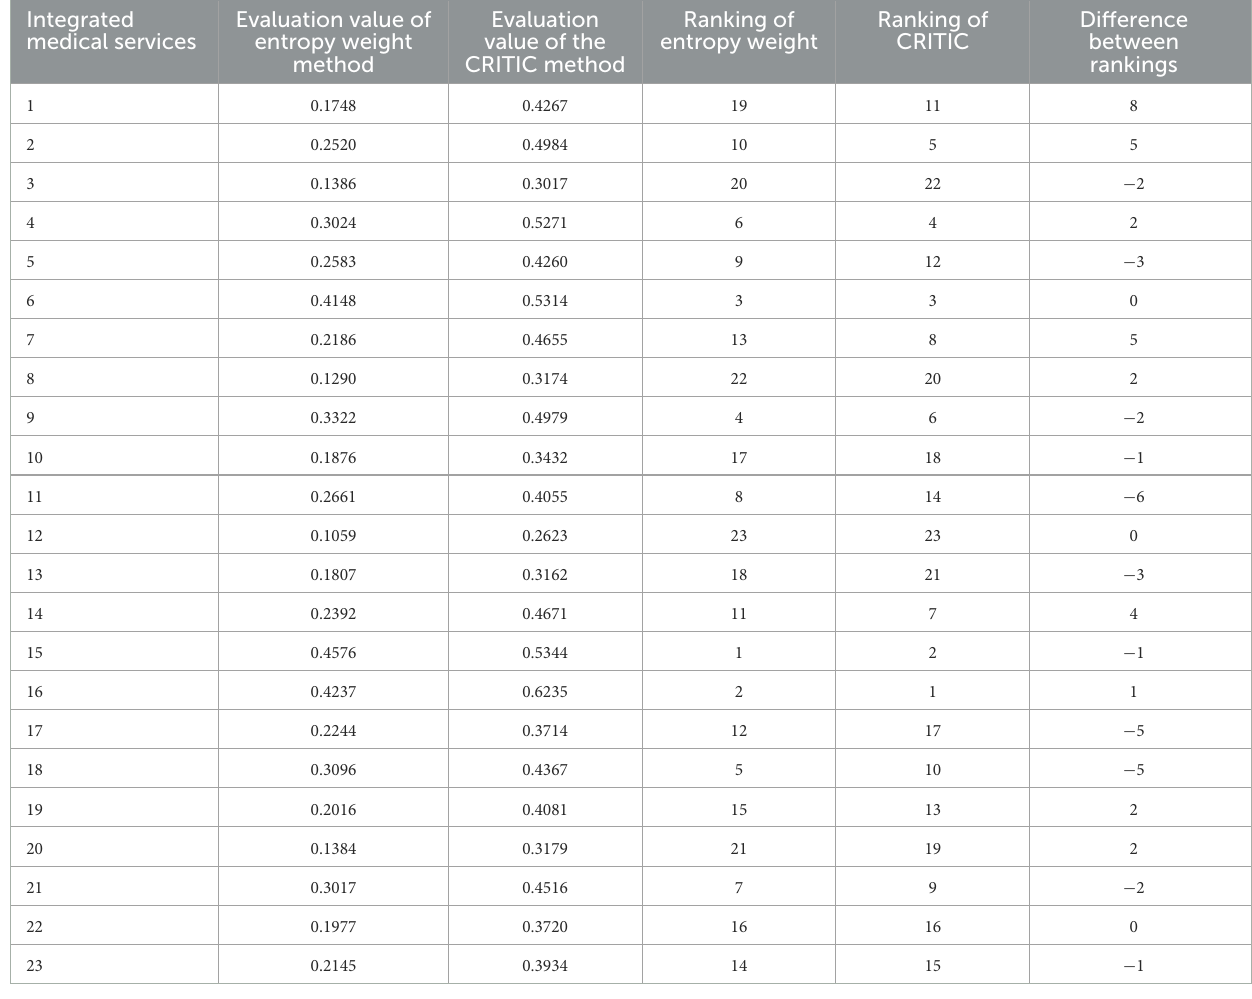
TABLE 3 Evaluation value and ranking of samples by CRITIC and entropy weight method in Fujian.